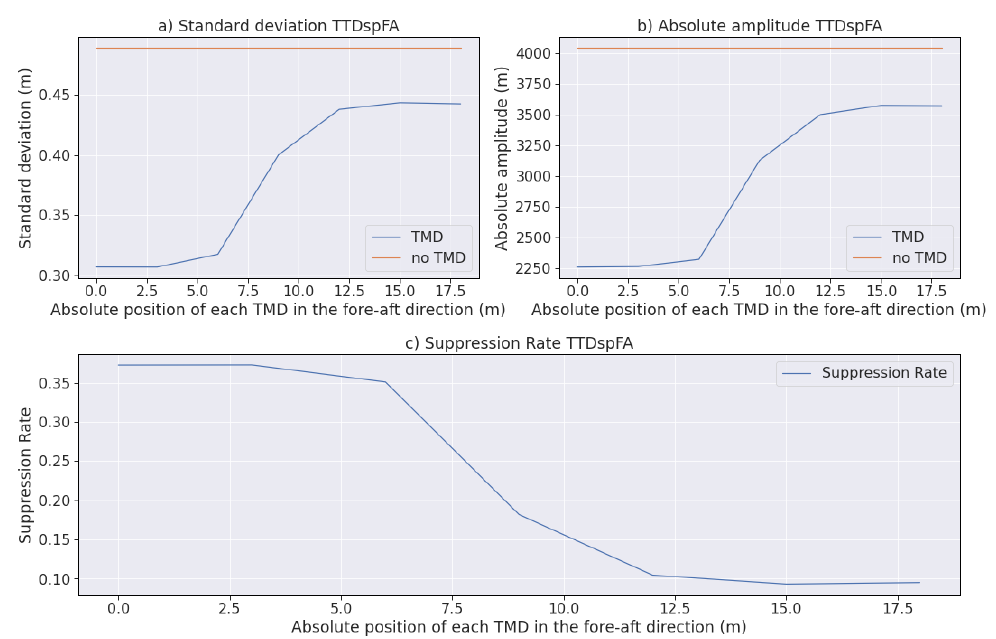
Figure 9. Results when moving two TMDs in the fore-aft direction keeping the same distance to the center. ( a ) Sum of TTDspFA standard deviation; ( b ) Sum of TTDspFA amplitude; and, ( c ) TTDspFA suppression rate.